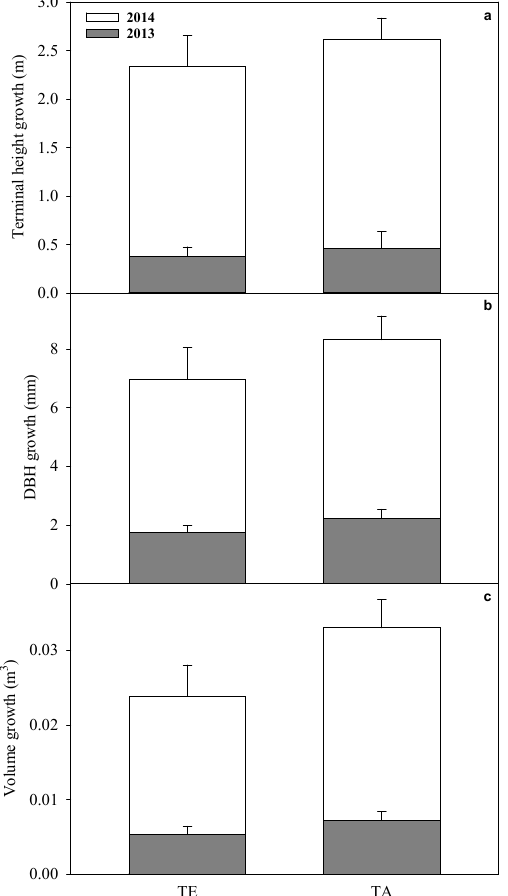
Figure 9. Total ( a ) height growth; ( b ) DBH growth; and ( c ) stem volume growth for 2013 and 2014 in response to 100% throughfall exclusion (TE) and ambient throughfall (TA) treatments. Error bars represent standard error of treatment means ( n = 5).